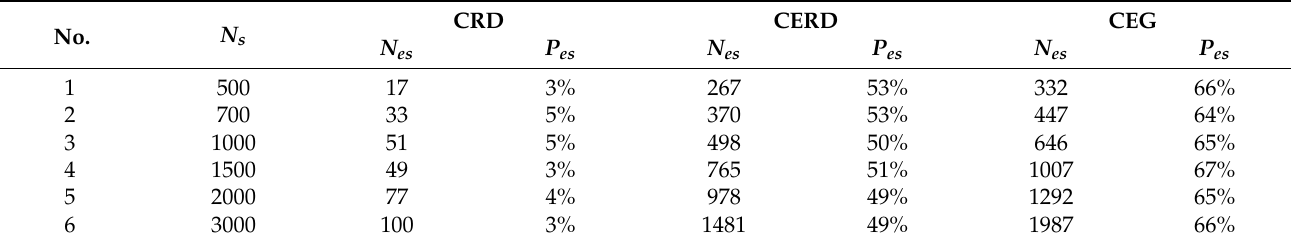
Table 4. The feasible solution generation efficiencies by different algorithms.